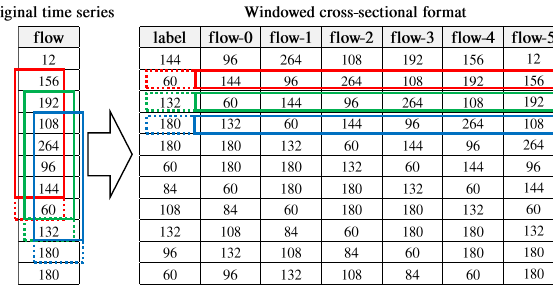
Figure 4. An example of original time series to windowed cross-sectional format conversion